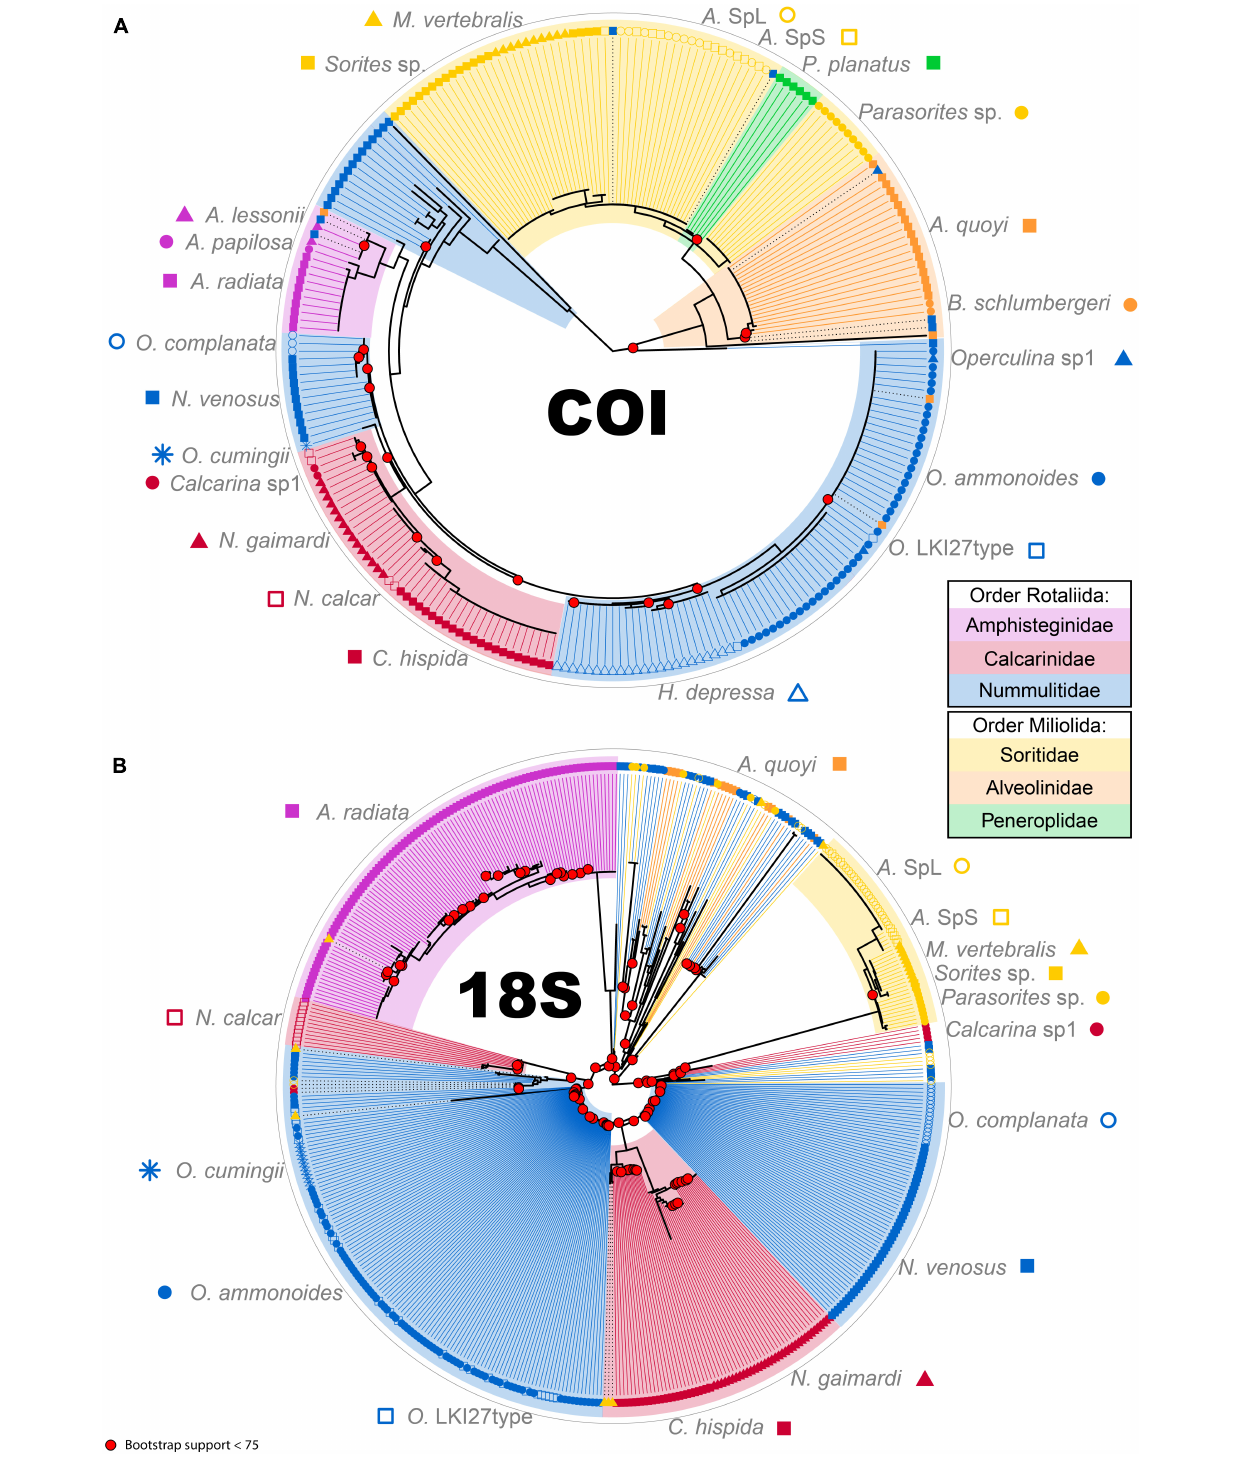
FIGURE 4 | Phylogenetic tree for COI marker (A) and 18S marker (B) . Colored areas represent the different families (Amphisteginidae, pink; Calcarinidae, dark red; Nummulitidae, blue; Soritidae, yellow; Alveolinidae, orange; Peneroplidae, green). Each species is represented by a symbol and colored according to the Family. The tips of the trees are ASV sequences in each sample. Black dotted lines between the phylogeny and the tip mean that the ASV does not cluster properly according to the morphological classification. Bootstrap values below 75 are highlighted at respective nodes in bright red.